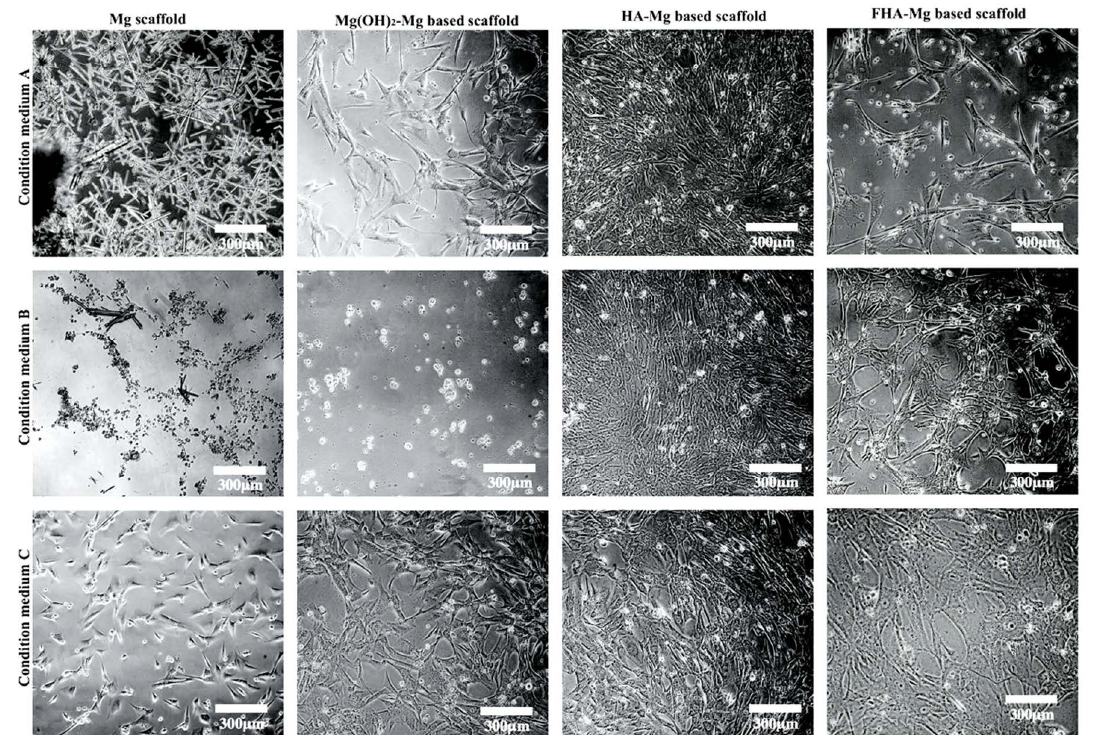
Figure 4. Images of hMSCs cultured for 2 days in conditioned media collected at different time points from uncoated Mg, Mg(OH) 2 -Mg, HA-Mg, and FHA-Mg scaffolds.